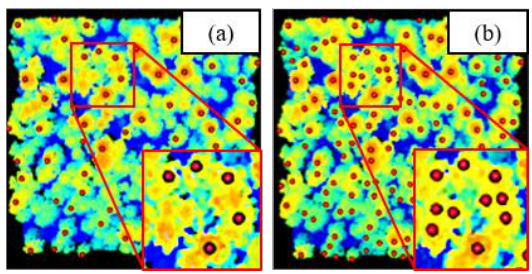
Figure 4 Comparison analysis for the 175 treetops extraction by two models: (a) 𝐶𝐻𝑀 model, (b) 𝐶𝑀𝑀